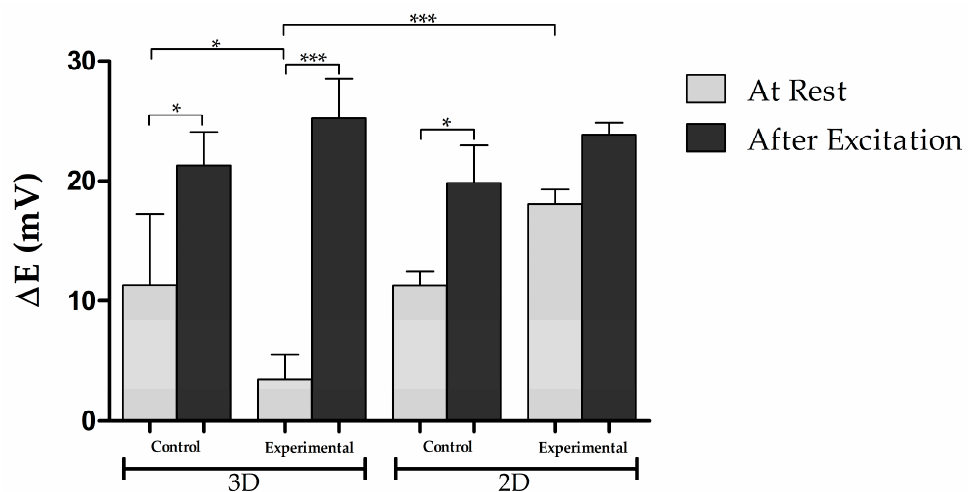
Figure 7. Electrical activity of 2D and 3D cultures (control and experimental) at resting membrane Figure 7 potential and after excitation with KCl. n = 3 for all groups. Values are given as average ± standard deviation. One-way ANOVA and Turkey post-hoc analysis was conducted, using a confidence level of 95%; * p < 0.05; *** p <